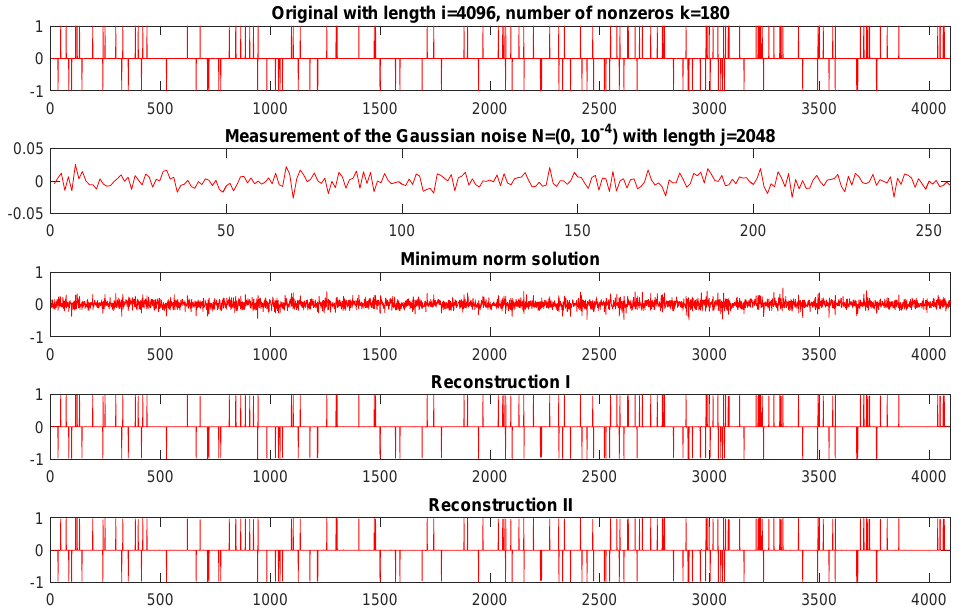
Figure 2. From top to bottom: the original signal, the noisy measurement, the minimum norm solution, the reconstruction signals respectively by Algorithm 1 ( µ n = 0.5) and Algorithm 2 .